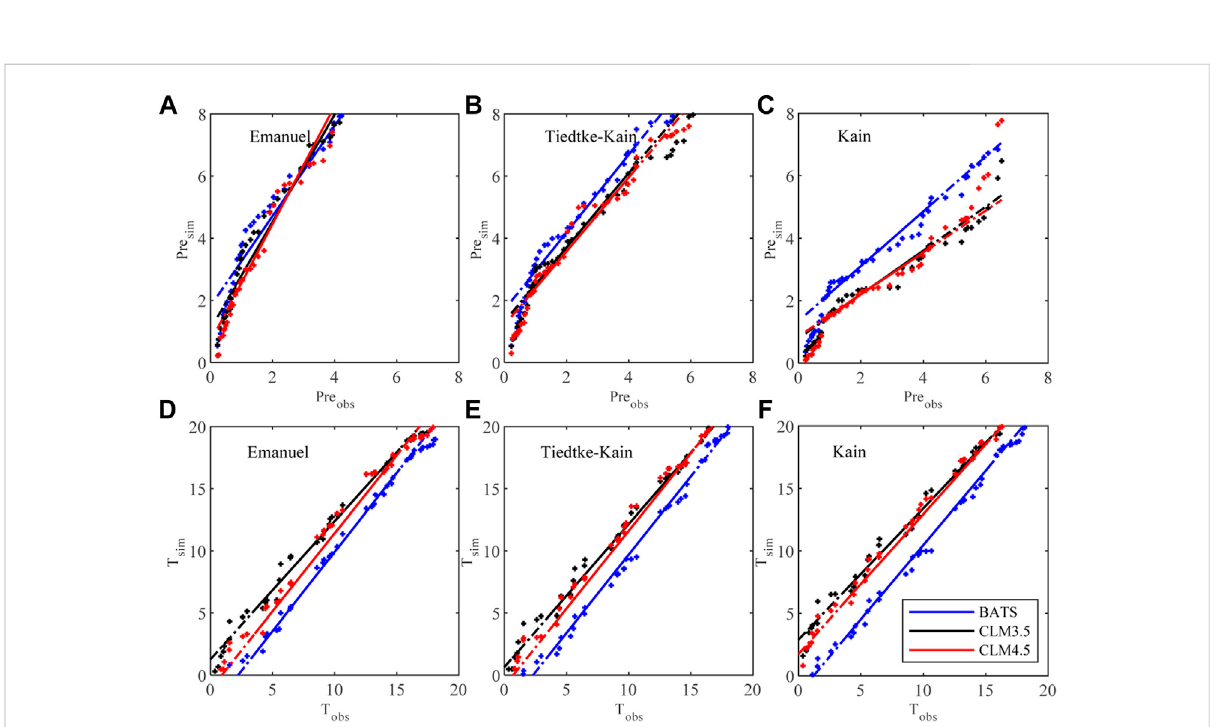
FIGURE 8 TheQ-Qplotofprecipitation (A – C) andtemperature (D – F) intheUYRBbetweenthesimulationandobservation.[ (A) precipitationsimulatedby Emanuel, (B) precipitation simulated by Tiedtke-Kain, (C) precipitation simulated by Kain-Fritsch, and (D – F) same as (A – C) but for the